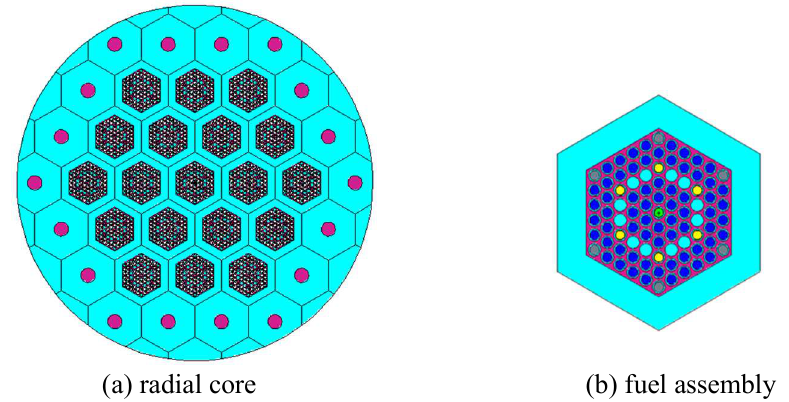
Figure 1. SmAHTR core and fuel assembly